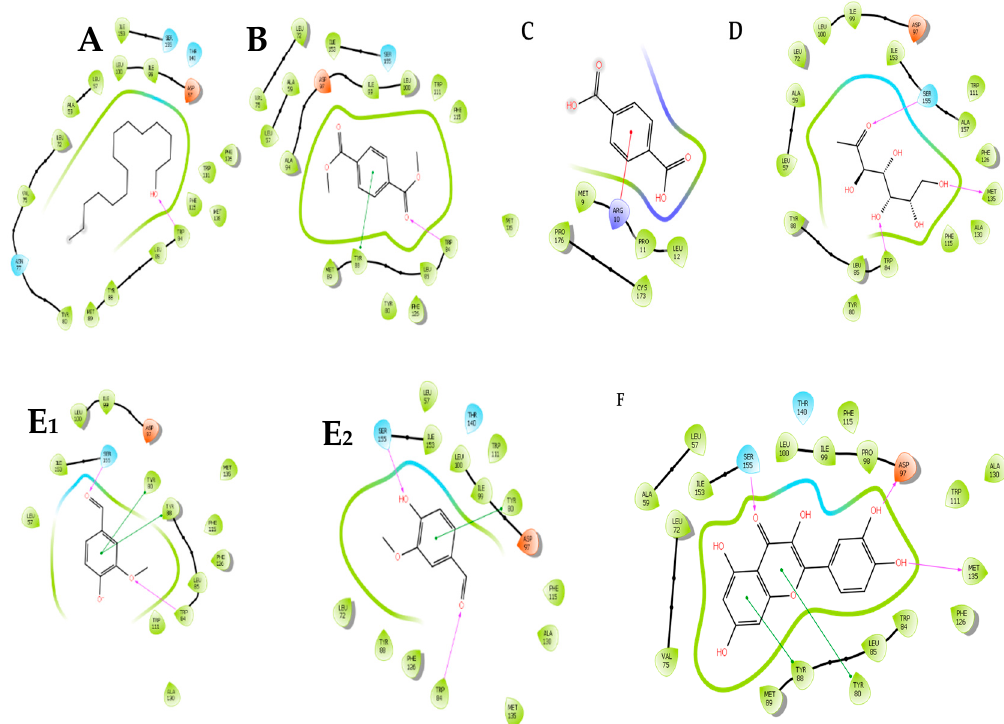
Figure 5. Interaction and binding of selected test compounds against the C. violaceum CviR protein active site. The negatively charged protein residues are indicated in red, polar residues are in cyan, hydrophobic residues are shown in parrot green, hydrogen interactions (H-bonds) are presented as pink / purple arrows, pi – pi stacking is shown as a green line, and the pi cation as a red line. A — Pentadecanol, B —Dimethyl terephthalate, C —Terephthalic acid, D —Methyl mannose, E1 and E2 — Vanillin, and F —Quercertin.